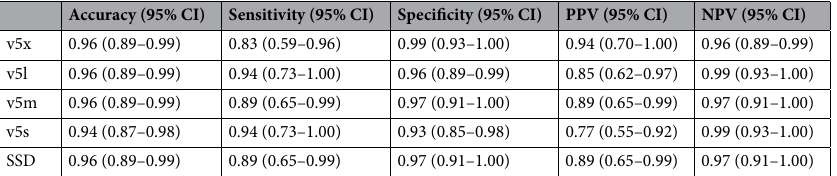
Table 2. Diagnostic performances of each model using the test dataset. CI Confidence interval, PPV Positive predictive value, NPV Negative predictive value, SSD Single shot multi-box detector.